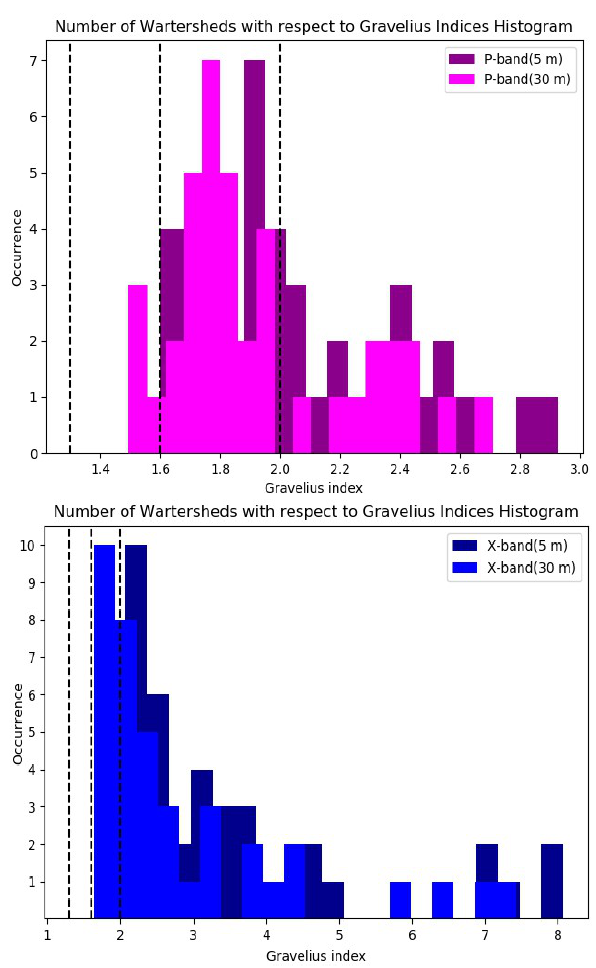
Figure 7. Histograms of the Gravelius compactness indices of drainage basins extracted from P-band radar DTM (top) and X- band radar DSM (bottom) in area B at 5 and 30